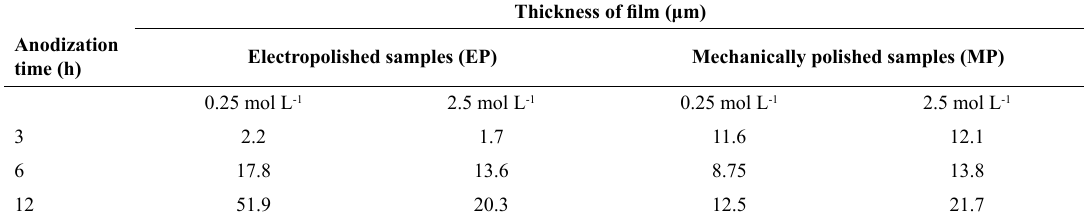
Figure 2. Anodization graphs for electropolished (a, b) and mechanically polished (c, d) titanium substrates in 0.25 (a,c) and 2.5 mol L -1 (b,d) H PO solutions. 3 4 Table 1. Thickness estimation of anodic film samples calculated according to Faraday's